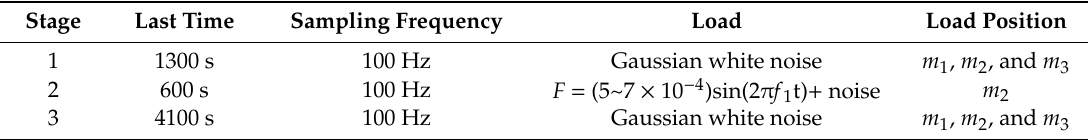
Table 1. Load information of the three stages.